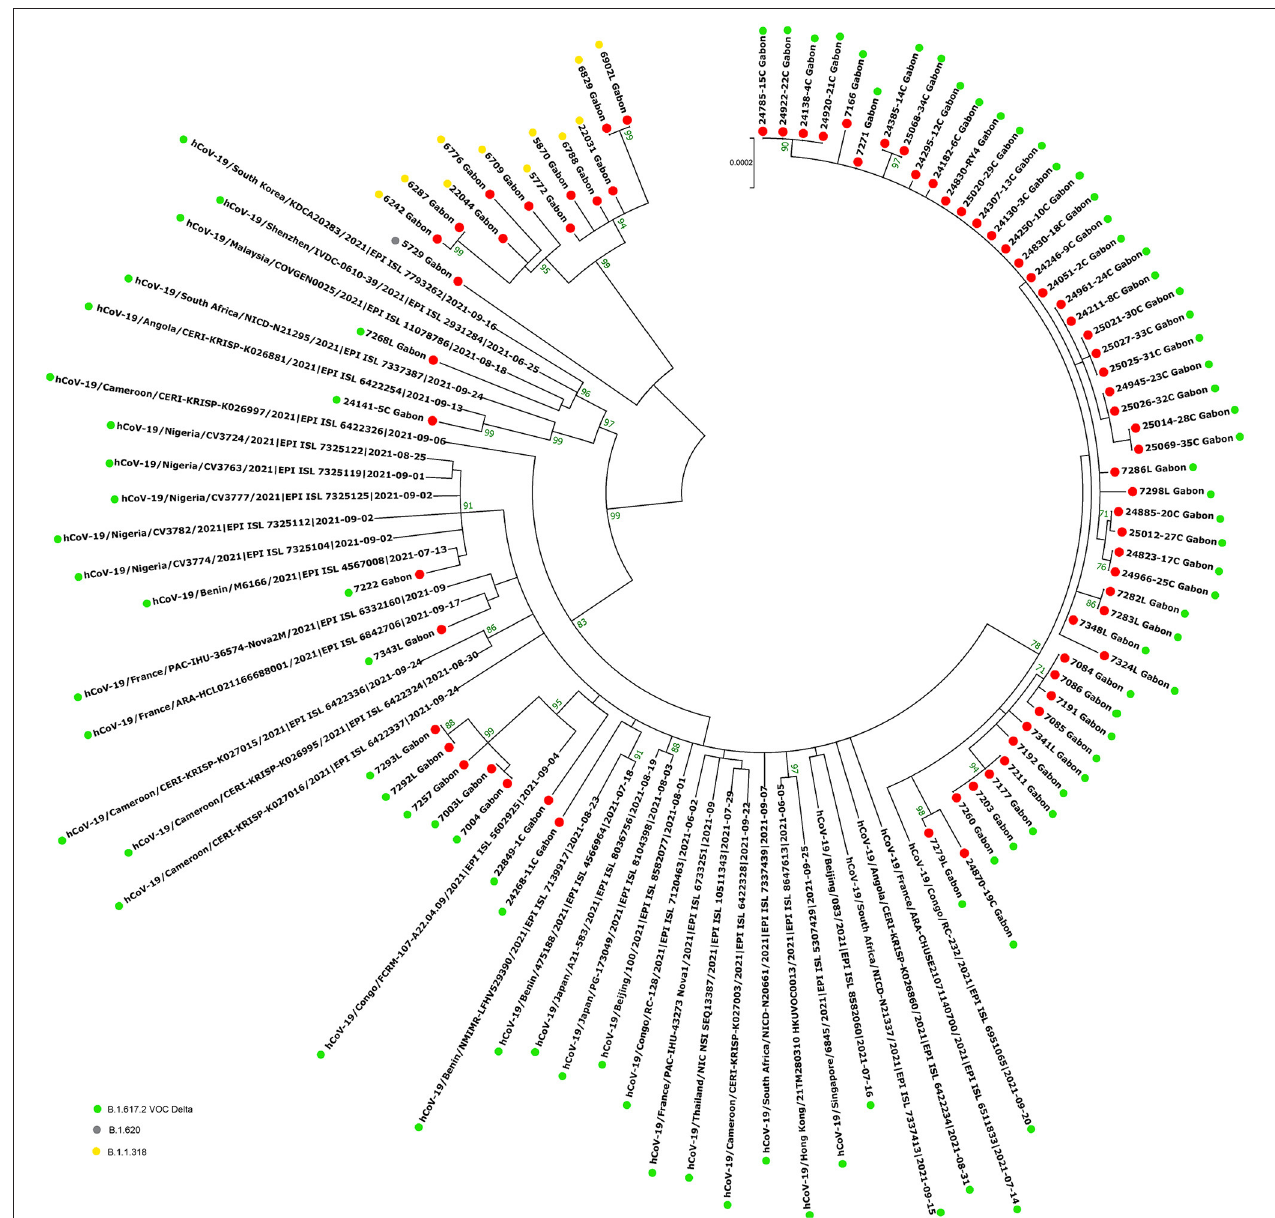
FIGURE 9 | Molecular Phylogenetic analysis by Maximum Likelihood method using 72 sequences from strains circulating during the second inter-wave and the third wave in Gabon and 35 SARS-CoV-2 sequences available in GISAID. The evolutionary history was inferred by using the Maximum Likelihood method based on the Jukes-Cantor model. The tree with the highest log likelihood ( − 45247.72) is shown. Initial tree(s) for the heuristic search were obtained automatically by applying Neighbor-Join and BioNJ algorithms to a matrix of pairwise distances estimated using the Maximum Composite Likelihood (MCL) approach, and then selecting the topology with superior log likelihood value. The tree is drawn to scale, with branch lengths measured in the number of substitutions per site. The analysis involved 107 nucleotide sequences. All positions with < 80% site coverage were eliminated. That is, fewer than 20% alignment gaps, missing data, and ambiguous bases were allowed at any position. There were a total of 28863 positions in the final dataset. Evolutionary analyses were conducted in MEGA7. The red circles correspond to the genomes identified in this study.